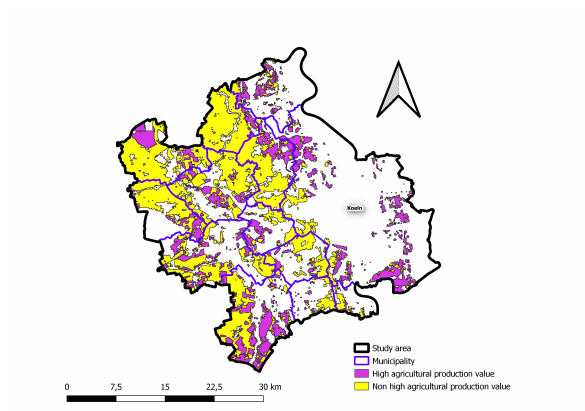
Figure 2. Agricultural areas in the study region. Large shares of the farmland are highly productive. Conversion of those areas to residential areas therefore faces high trade-offs with respect to agricultural productivity.